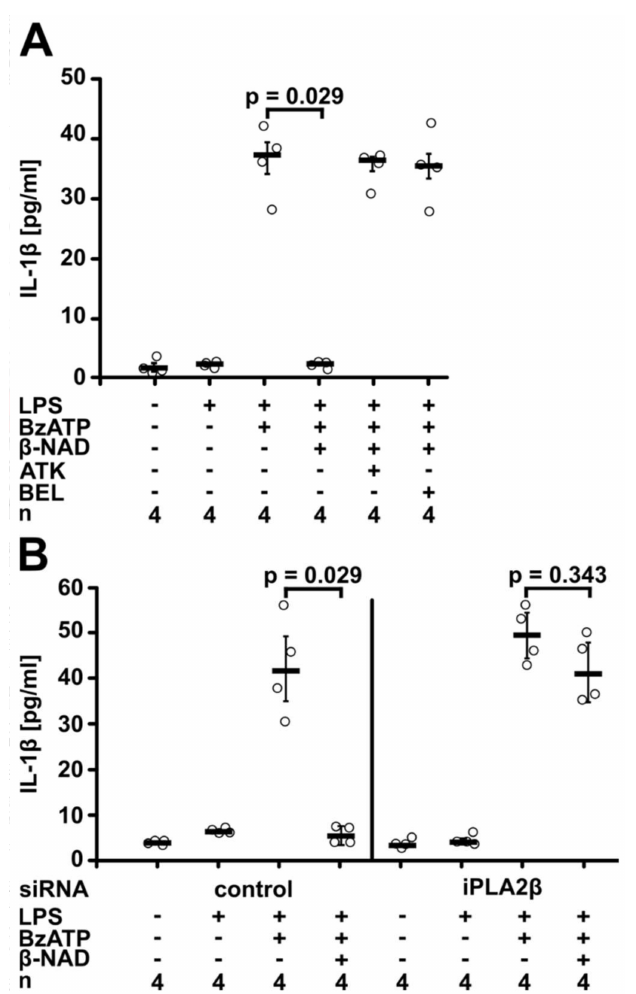
Figure 4. β -NAD signaling involves iPLA2 β . Human monocytic U937 cells were primed with LPS (1 µ g/mL, 5 h) and activated with 2 (cid:48) (3 (cid:48) )- O -(4-benzoylbenzoyl)adenosine-5 (cid:48) -triphosphate (BzATP; 100 µ M, 30 min). β -NAD was used at a concentration of 1 mM. The concentration of IL-1 β in the cell culture supernatant was measured by ELISA. ( A ) Experiments were performed in the presence or absence of the general inhibitor of PLA2 arachidonyl trifluoromethyl ketone (AKT; 50 µ M) or of the more specific iPLA2 inhibitor bromoenol lactone (BEL; 50 µ M). ( B ) U937 cells were transfected with control siRNA or with siRNA targeting iPLA2 β ( PLA2G6 ). Data are presented as individual data points, bars indicate median, whiskers encompass the 25th to 75th percentile, Kruskal-Wallis test followed by the Mann-Whitney rank sum